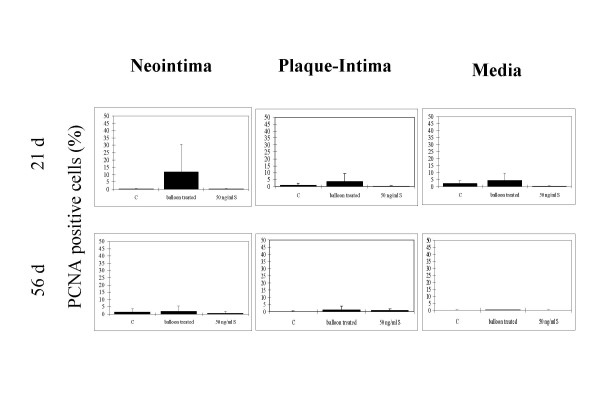
In the ex vivo HOC-model the effect of a 21 days incubation with SRL (50 ng/ml) on reactive cell proliferation was studied in the neointima, plaque-intima, and media at day 21 and day 56. SRL inhibited reactive cell proliferation, statistical significance was achieved for the inhibitory effect on cell proliferation in the media at day 21 (SI/MPL-ratio: 7.81).